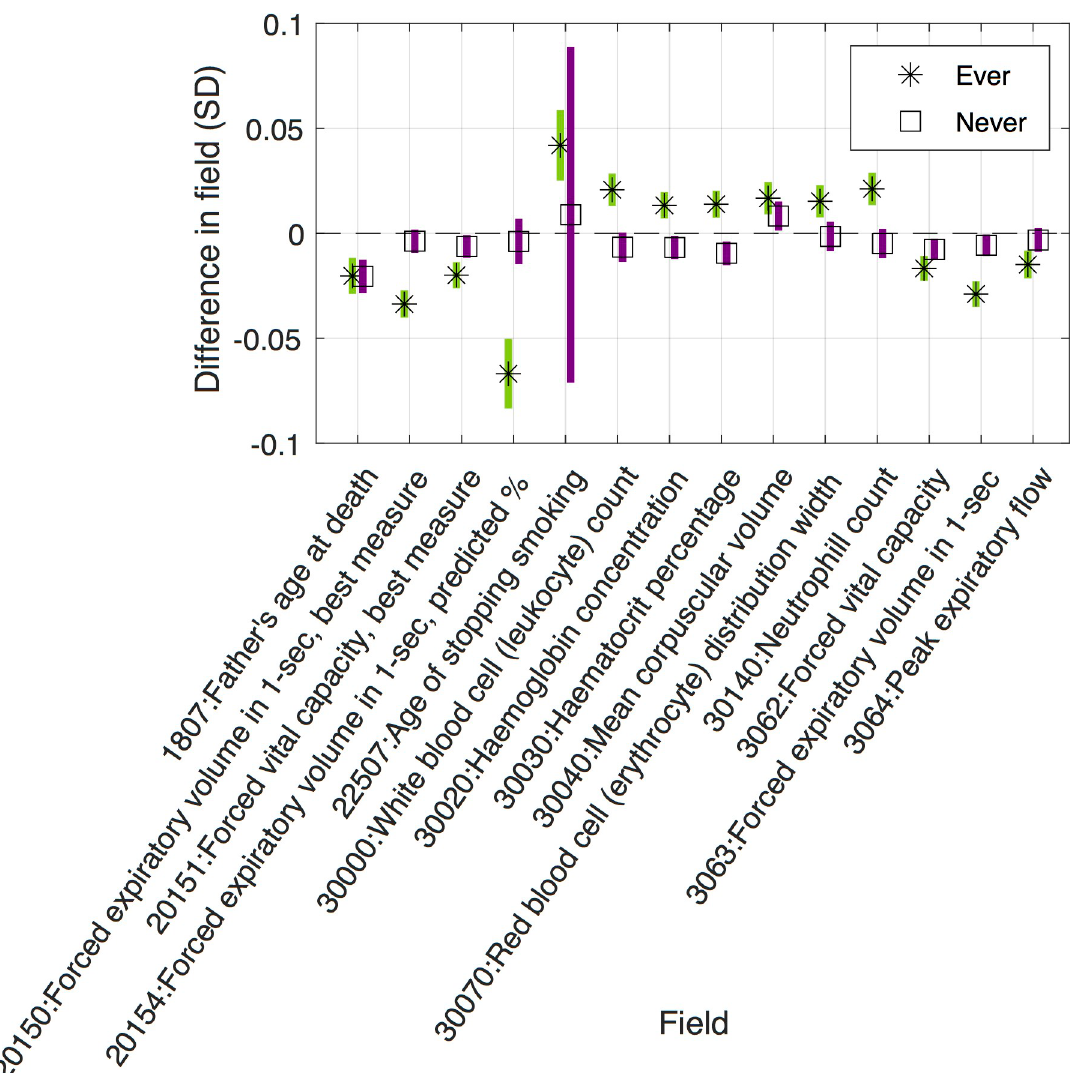
Fig 4. Identified main effects from MR-pheWAS in ever smokers, for continuous outcomes. Results shown are those identified after correcting for multiple testing. 14 of 18 linear results are shown in this figure, with PHESANT linear result for never smokers. Results not shown in this figure are relevant to smoking participants only, e.g. “amount of tobacco currently smoked” such that they are absent in the never smokers (see S3 Table for further